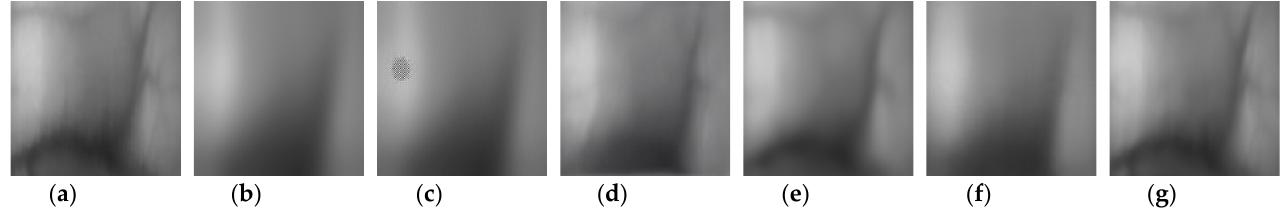
Figure 14. Examples of restored SDU-DB finger-vein images using the state-of-the-art methods and the proposed RMOBF-Net (motion blur with Gaussian blur filter of 19 × 19): ( a ) original image, ( b ) blurred image and images restored by ( c ) DeblurGAN, ( d ) DeblurGANv2( e ) SRN-DeblurNet, ( f ) MPRNet, and ( g ) RMOBF-Net.